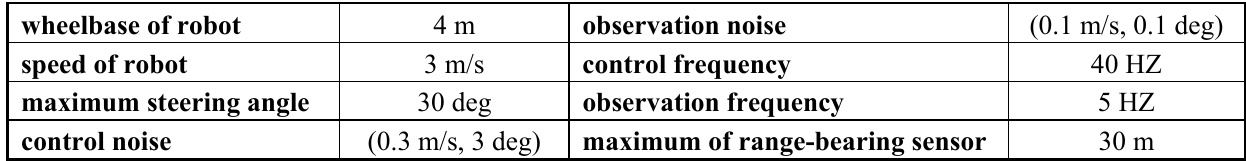
Table 2. Parameter settings used in the simulation.